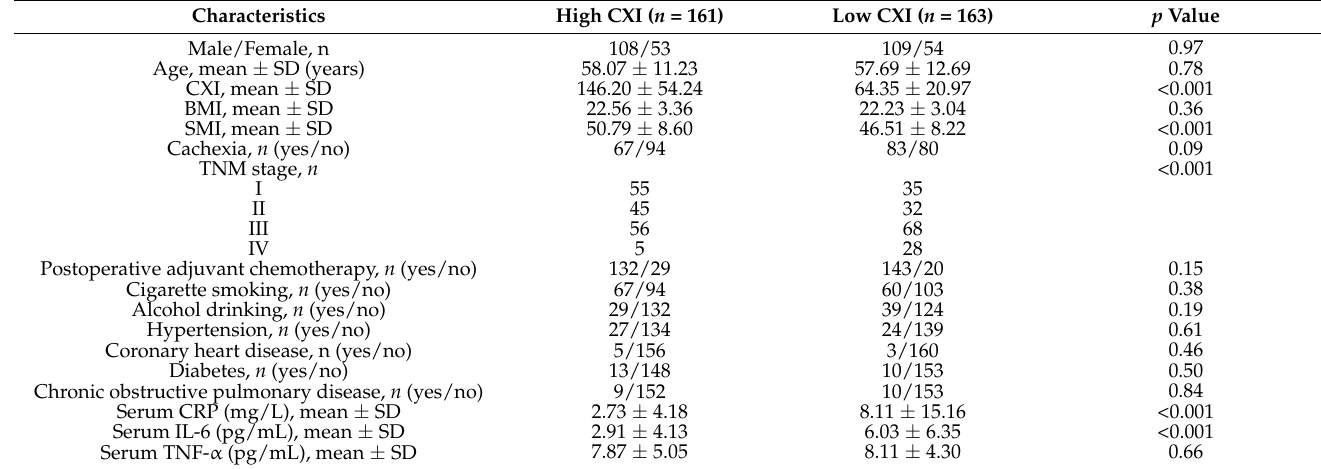
Table 1. Clinical characteristics between patients in low and high CXI groups.